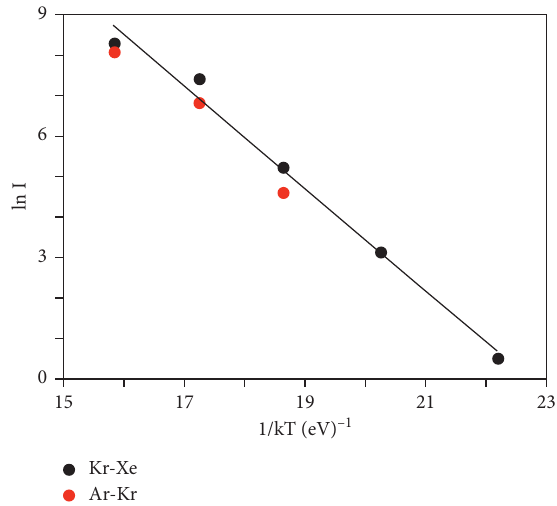
Figure 7: Dependence of 610.4nm lithium line intensity in Kr-Xe and Ar-Kr mixtures on the inverse temperature of lithium layer.